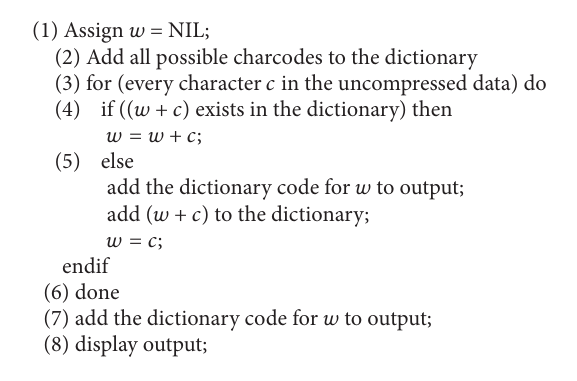
Algorithm 2: Text compression algorithm.